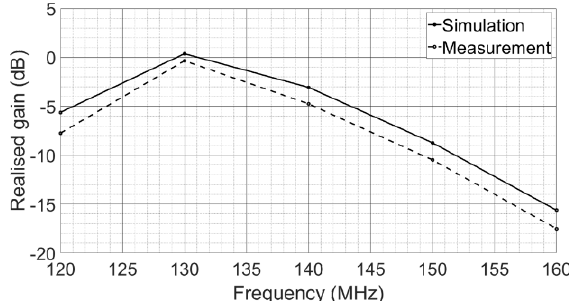
Figure 16. Measured and simulated realized gain of the miniaturized and matched antenna A5.